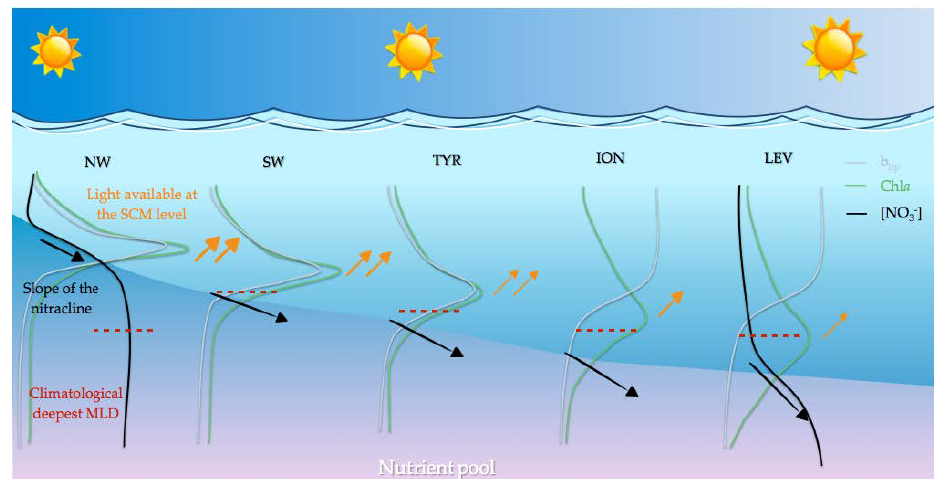
Figure 12. Schematic representation of the different situations of SCMs in the Mediterranean Sea during the oligotrophic summer period for the five considered regions of the Mediterranean Sea along the west-to-east